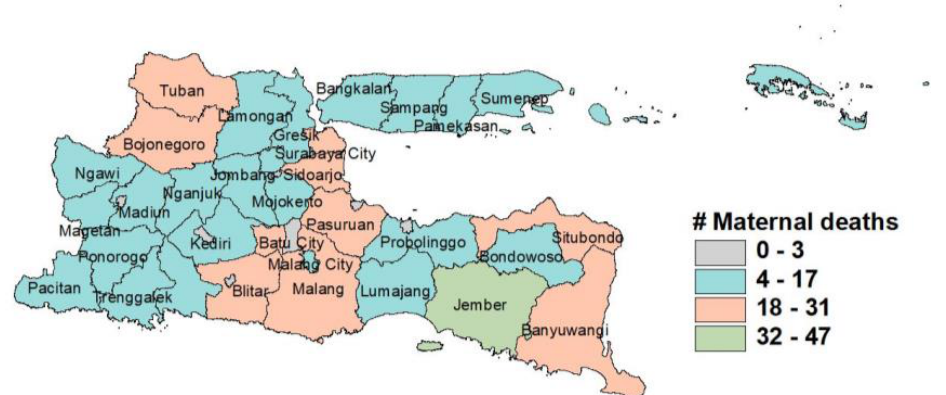
Figure 3. Distribution of the number of maternal deaths in East Java in 2019.